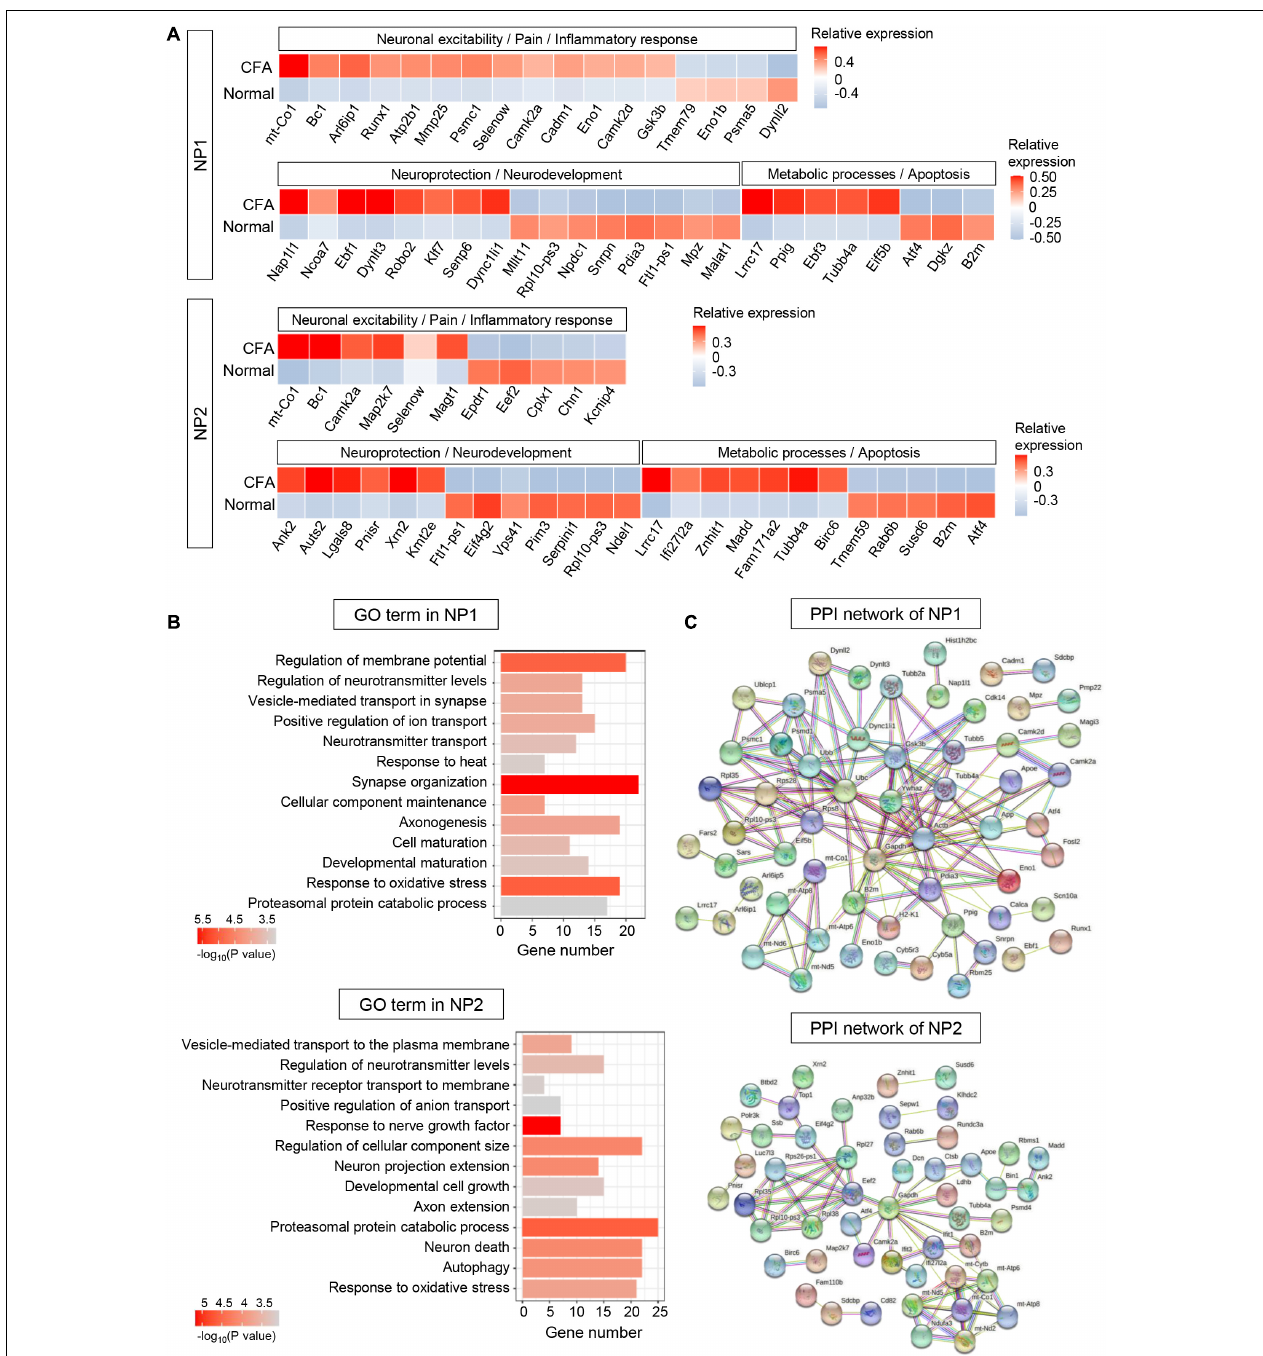
FIGURE 6 | Transcriptional responses of NP neurons in mouse TG to orofacial inflammation revealed by scRNA-seq. (A) Heatmap of identified DEGs within NP1 and NP2 neurons under normal and orofacial inflammatory pain conditions. Red colors indicate upregulated expression level in the heatmap, while blue colors indicate downregulated expression level. (B) The enriched GO biological process terms of identified DEGs in NP1 and NP2 neurons following orofacial inflammation. The number of genes is plotted as the abscissa and enriched GO biological process term is plotted as the ordinate. The colors correspond to p -value range. (C) PPI network analysis of identified DEGs in NP1 and NP2 neurons following orofacial inflammation. The top hub genes in NP1 are Actb (degree = 23), Ubc (degree = 15), Ywhaz (degree = 12), Gsk3b (degree = 11), and mt-Co1 (degree = 7), while top hub genes in NP2 are Gapdh (degree = 14), Eef2 (degree = 7), mt-Atp6 (degree = 7), mt-Co1 (degree = 7), and Rpl10-ps3 (degree = 5), etc. The line color indicates the type of interaction evidence, and line thickness indicates the strength of data support. Blue represents known interactions from curated databases, while purple represents experimentally determined interactions. Green, red, and royal blue represent gene neighborhood, gene fusions and gene co-occurrence, respectively. TG, trigeminal ganglion; scRNA-seq, single-cell RNA-sequencing; DEGs, differentially expressed genes; CFA, complete Freund’s adjuvant; NP, non-peptidergic nociceptors; PPI, protein–protein interaction.